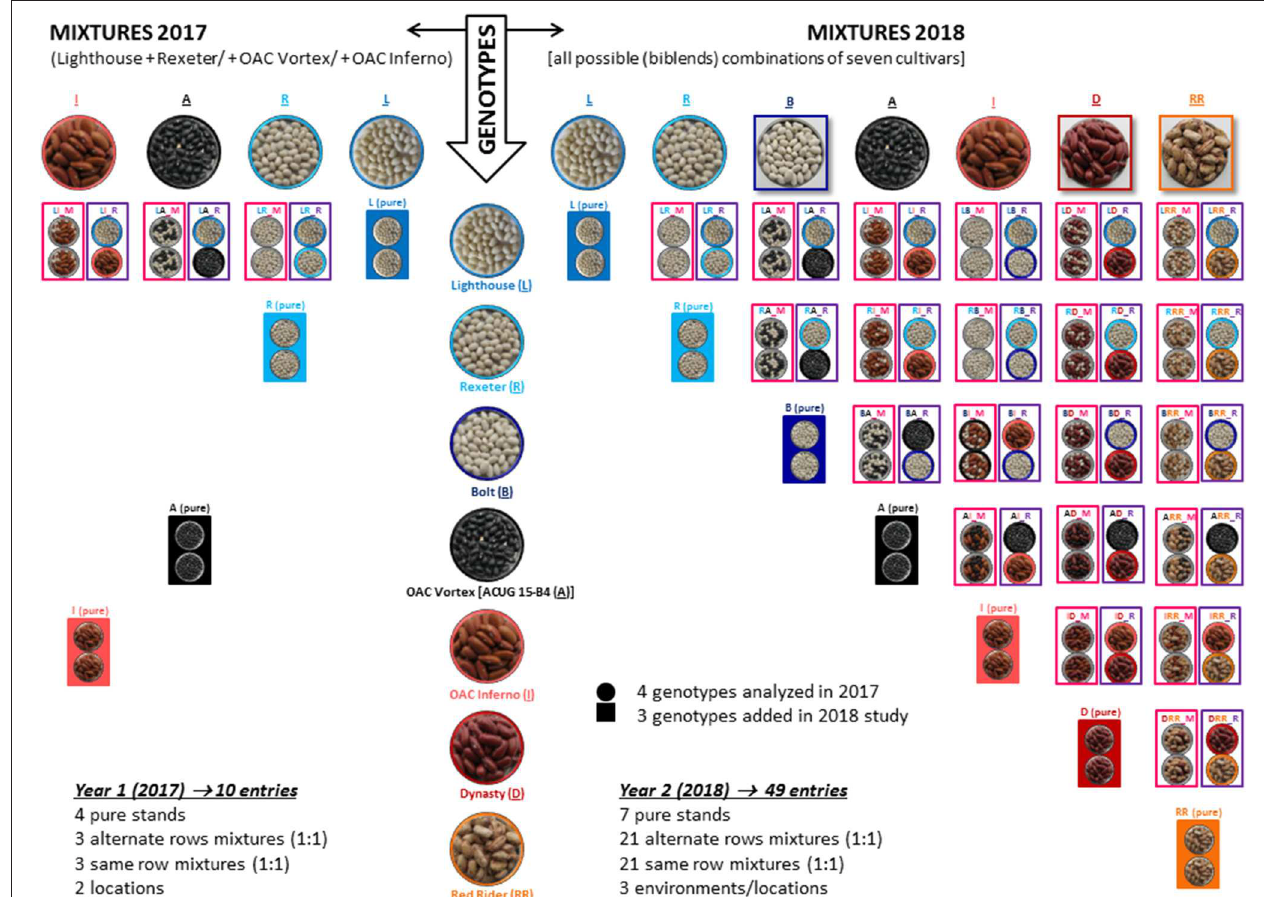
FIGURE 1 | Formation or binary mixtures among seven common bean cultivars evaluated in three Ontario environments/locations over 2 years. All mixtures were formed by mixing two genotypes in a 1:1 seed number ratio. In 2017 (left), mixtures were formed with four cultivars [Lighthouse (white), Rexeter (white), OAC Vortex (black), and OAC Inferno (light red kidney)]; Lighthouse was mixed with one of the remaining three genotypes. In 2018 (right), binary mixtures were formed in all possible combination of seven cultivars [Lighthouse, Rexeter, Bolt (white), OAC Vortex, OAC Inferno, Dynasty (dark red kidney), and Red Rider (cranberry)]. Genotypes were evaluated in pure stands and two types of binary mixtures [alternate rows mixture (ARM) and same row (complete random) mixture (SRM)]. An equal proportion replacement (substitutive) design at a single density was used as a mixing technique ( Jolliffe, 2000). Mixture names are composed of three letters: the first letter indicates cultivar component 1 [L (Lighthouse), R (Rexeter), B (Bolt), A (OAC Vortex, work initiated with the test name ACUG 15-B4), I (OAC Inferno), D (Dynasty), and RR (Red Rider)], the second letter indicates cultivar component 2 and the third letter represents mixture type [M stands for the same row mixture (SRM) and R is for the alternate row mixture (ARM)]. Mixtures and pure stands had the same density (n) and each mixture component had an n/2 density (for details Figure S1